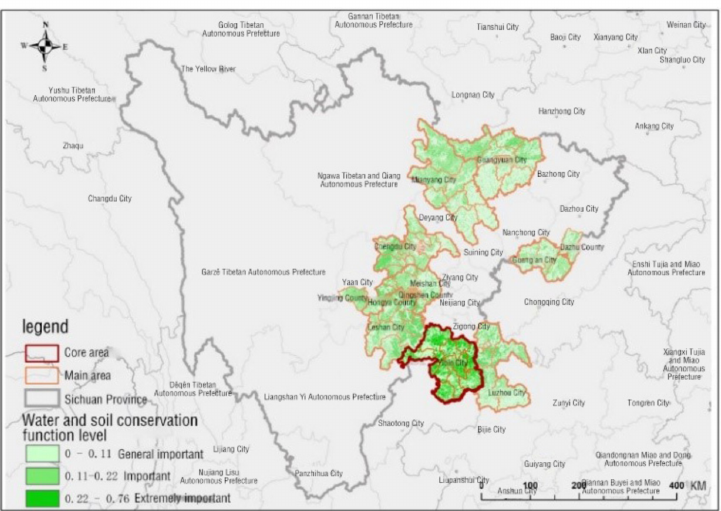
Figure 8. Conservation of water and soil analysis of research areas in Sichuan Province.